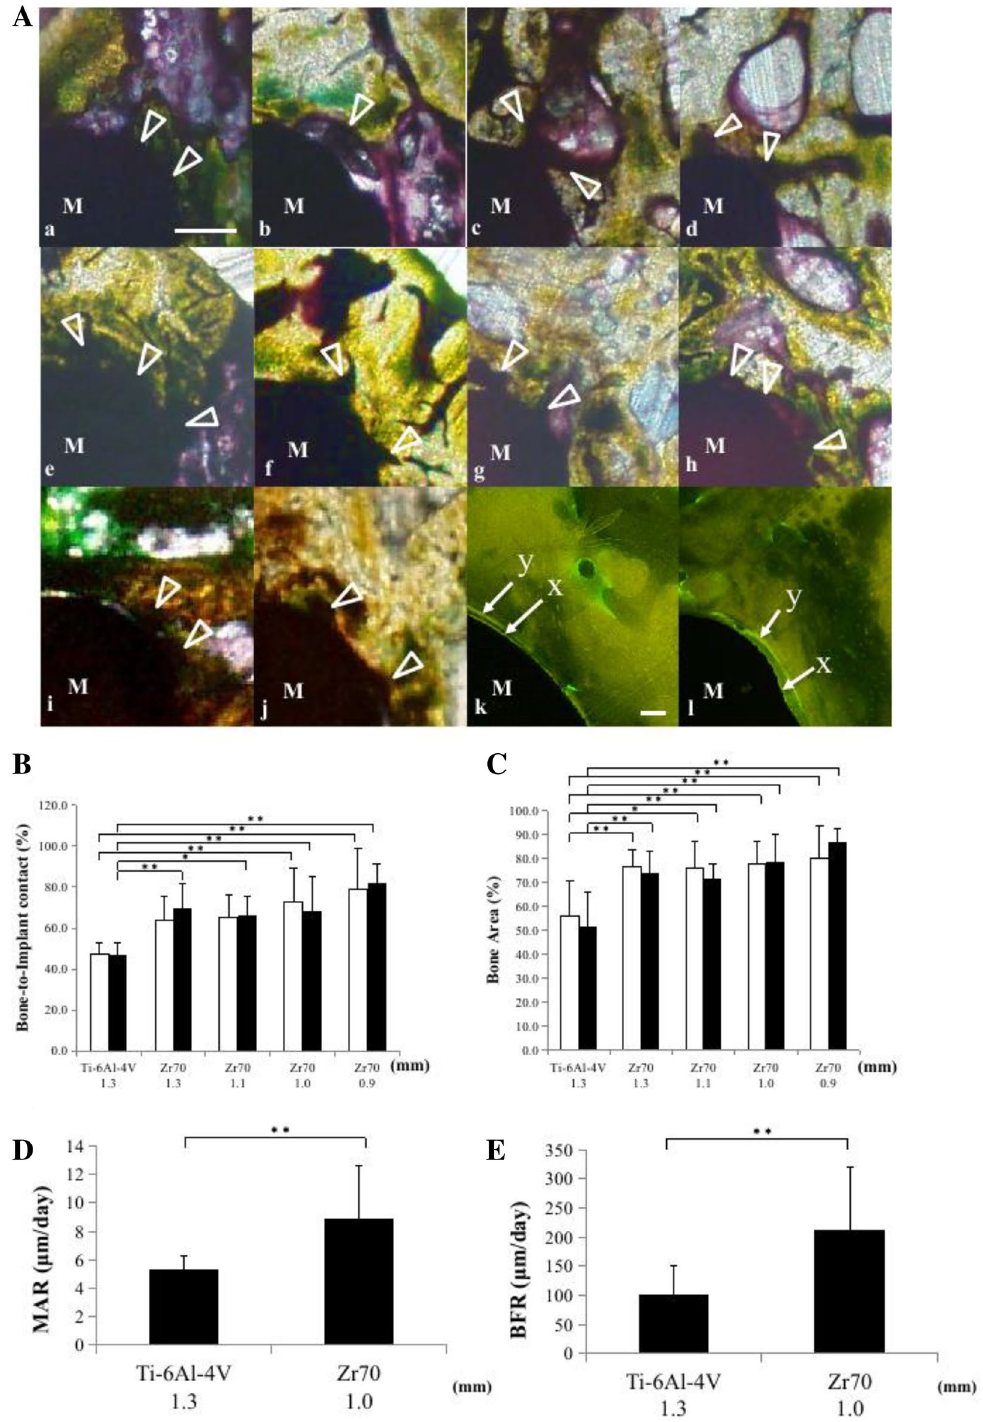
Figure 4. Non-decalcified tissue section image and histomorphometric analysis of bone around the miniscrew. ( A ) The tissue images of 1.3 mm diameter Ti-6Al-4 V miniscrew ( a , b ), and 1.3 mm diameter ( c , d ), 1.1 mm diameter ( e , f ), 1.0 mm diameter ( g , h ) and 0.9 mm ( i , j ) diameter Zr 70 Ni 16 Cu 6 Al 8 BMG miniscrews at 8 weeks post-implantation. The tissue images of the non-loaded group were ( a ), ( c ), ( e ), ( g ), and ( i ). The tissue images of the 200 gf loaded group were ( b ), ( d ), ( f ), ( h ), and ( j ). The arrowhead indicates the newly formed bone (dark purple stained area). The fluorescence microscope images of the Ti-6Al-4 V miniscrew and the Zr 70 Ni 16 Cu 6 Al 8 BMG miniscrew are shown in ( k ) and ( l ), respectively. Calcein green label (x) and tetracycline label (y) are shown. Scale bars, 250 μm: a, b, c, d, e, f, g, h, i, and j, 50 μm: k and l. ( B ): BIC of each miniscrew in the non-loaded group ( □ ) (n = 5 for 1.3 mm, n = 8 for 1.1 mm, n = 6 for 1.0 mm, n = 7 for 0.9 mm diameter) and the 200 gf loaded group ( ■ ) (n = 5 for 1.3 mm, n = 5 for 1.1 mm, n = 7 for 1.0 mm, n = 7 for 0.9 mm diameter). ** P < 0.01, * P < 0.05. ( C ) BA of each miniscrew in the non-loaded group ( □ ) (n = 5 for 1.3 mm, n = 8 for 1.1 mm, n = 6 for 1.0 mm, n = 7 for 0.9 mm diameter) and the 200 gf loaded group ( ■ ) (n = 5 for 1.3 mm, n = 5 for 1.1 mm, n = 7 for 1.0 mm, n = 7 for 0.9 mm diameter). ** P < 0.01, * P < 0.05. ( D ) MAR of Ti-6Al-4 V miniscrew and Zr 70 Ni 16 Cu 6 Al 8 BMG miniscrew (n = 6 per group). ** P < 0.01, * P < 0.05. E: BFR of Ti-6Al-4 V miniscrew and Zr 70 Ni 16 Cu 6 Al 8 BMG miniscrew (n = 6 per group). ** P < 0.01, * P <